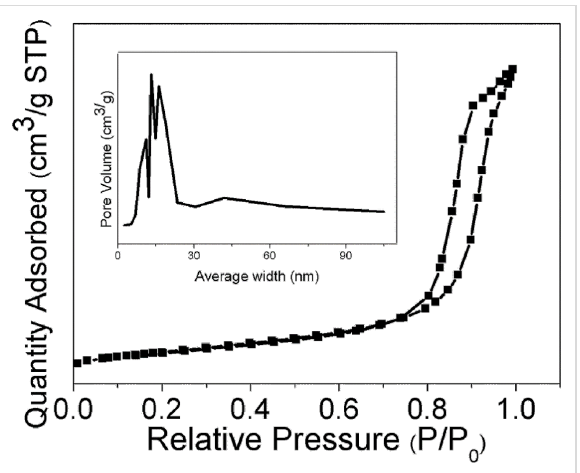
Figure 7: UV–vis absorption spectra of a) TiO 2 , b) 3.0 wt % Pd/TiO 2 , c) 0.5 wt % Pd/TiO 2 and d) 1.0 wt % Pd/TiO 2 .